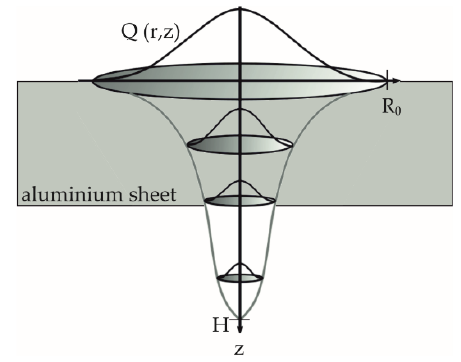
Figure 7. The modified heat source model applied to an aluminium alloy sheet.